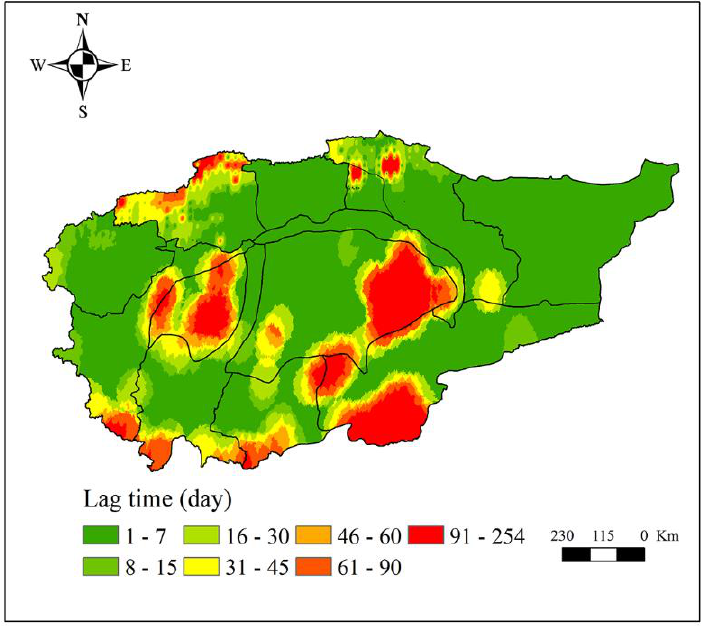
Figure 6. The lag time of hydrological drought to meteorological drought. We also discuss the spatial response of hydrological drought to meteorological drought from the perspectives of different time scales. First, the SPI and SWSI of each grid were calculated. Next, the EEMD decomposition of SPI and SWSI of each grid was performed, and the components of SPI and SWSI on the month scale, inter-annual scale, and inter- decadal scale were calculated, respectively. Lastly, the correlation between the SPI and SWSI on different time scales was separately obtained. On the monthly time scale (refer to Figure 7), the correlation between hydrological and meteorological droughts is positive (i.e., Figure 7a) and passes the significance test (i.e., Figure 7b). Only the sporadic area reports a negative correlation in the Qarqan river basin and fails to pass the significance test. The correlation between hydrological and meteorological drought is relatively high in the Aksu, Weigan, Yarkant, and Kashgar river basins, but the correlation is relatively low in other basins, especially the Taklimakan desert. On the interannual time scale (refer to Figure 8), the spatial pattern is similar to the spatial pattern on the monthly time scale, and the correlation between hydrological and meteorological droughts is positive (Figure 8a) and passes the significance test. Furthermore, some sporadic area depicts a negative correlation in the Qarqan and Keliya river basins, and desert area; those areas all fail to pass the significance test (i.e., Figure 8b). The correlation between the mountainous areas of Aksu, Weigan, Kaikong, Yarkand, Hotan, and Kashgar river basins was relatively high. On the inter-decadal time scale (refer to Figure 9), the spatial pattern is complex, and the correlation between hydrological and meteorological droughts in mountainous areas is positive while the correlation between them is negative in the Taklimakan and Kumtag deserts, and some plain areas. From Figure 9a, it is evident that the positive and negative correlations between meteorological and hydrological droughts are staggered, and the correlation between them is higher than the correlation on the monthly and inter-annual time scales. Hence, hydrological drought is more affected by meteorological drought on a long time